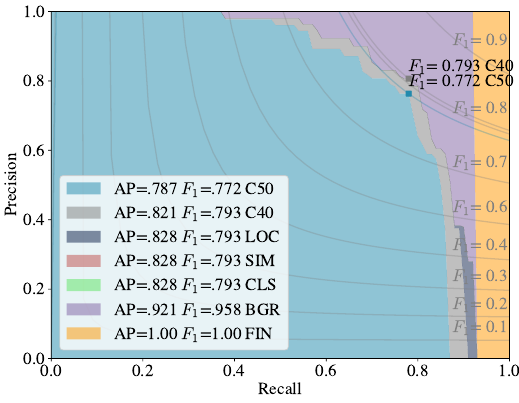
Figure 8. Precision-recall (PR) analysis: PR curves of the trained Sa et al. [8] early fusion network. C50, C40 and LOC correspond to PR curves for IoU values of 0.5, 0.4 and 0.1, LOC when all localisation errors are removed. SIM and CLS when errors from similar categories and all classification labels are removed. BGR is the PR curve when all other class/background false positives are removed and finally FIN shows PR containing no